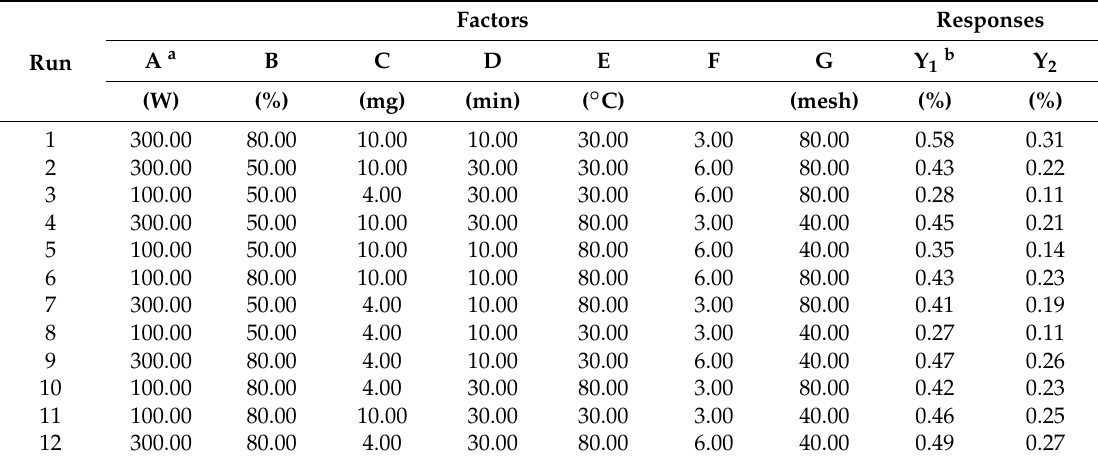
Table 2. Real values of the variables in the Plackett-Burman design and experimental data of the yields of total flavonoids and ginkgolides from Ginkgo biloba fallen leaves ( n = 3). Factors Run